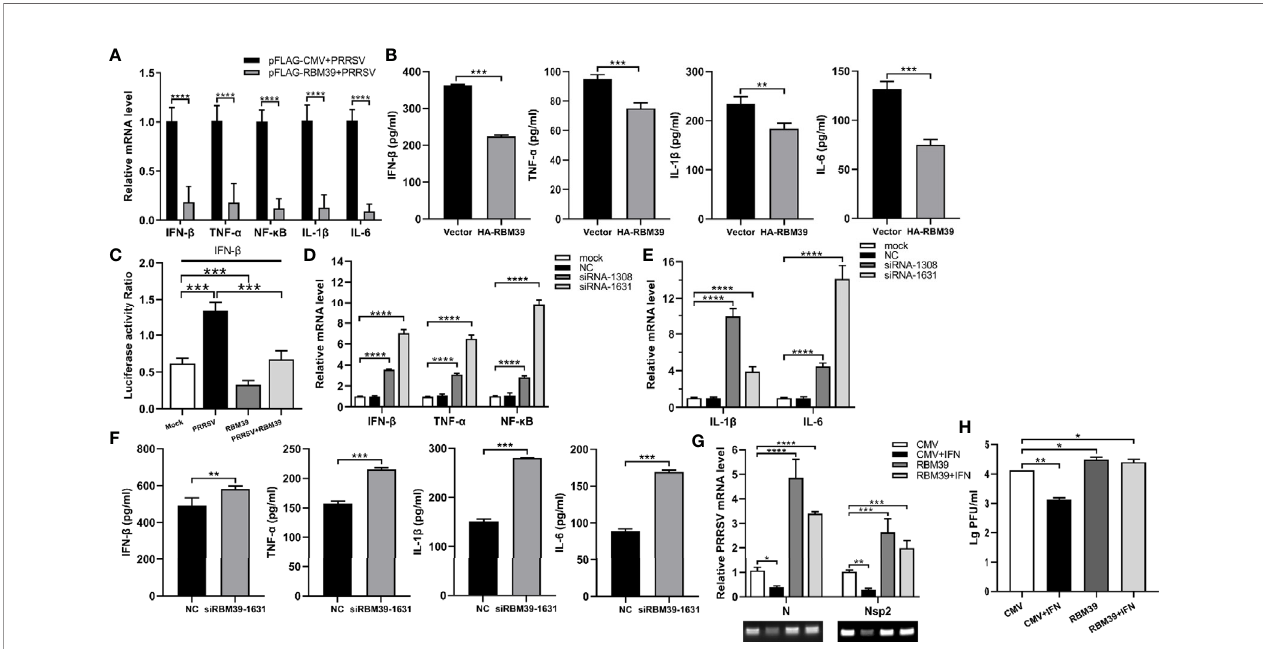
FIGURE 4 | The promotion of PRRSV proliferation by RBM39 is related to innate immunity. 3D4/21 cells were transfected with Flag-RBM39 or empty vector plasmid (A, B, G, H) , siRNA of RBM39 or NC (D – F) and the infected with PRRSV 12 h post-transfection. The mRNA levels of IFN- b , TNF- a , NF- k B, IL-1 b , IL-6 were determined by qRT-PCR at 24 h post-infection (A, D, E) . Cytokine detection in the condition of RBM39 overexpressed (B) or interfered (F) by ELISA kits (Solarbio). (C) HEK293 T cells were transfected or co-transfected with HA-RBM39 and PRRSV infectious clone plasmid. The luciferase activity of IFN- b promoter reporter gene was measured through Dual Luciferase Reporter Gene Assay Kit (Yeasen Technology). (G) The cells were treated with IFN post-infection. After another 24 h, mRNA levels of PRRSV N and nsp2 were tested by qRT-PCR. (H) Detection of viral titers of PRRSV in cell supernatants after IFN treated. Data are representative of results from three independent experiments. The statistically signi fi cant at P-value was demonstrated in Statistical Analysis